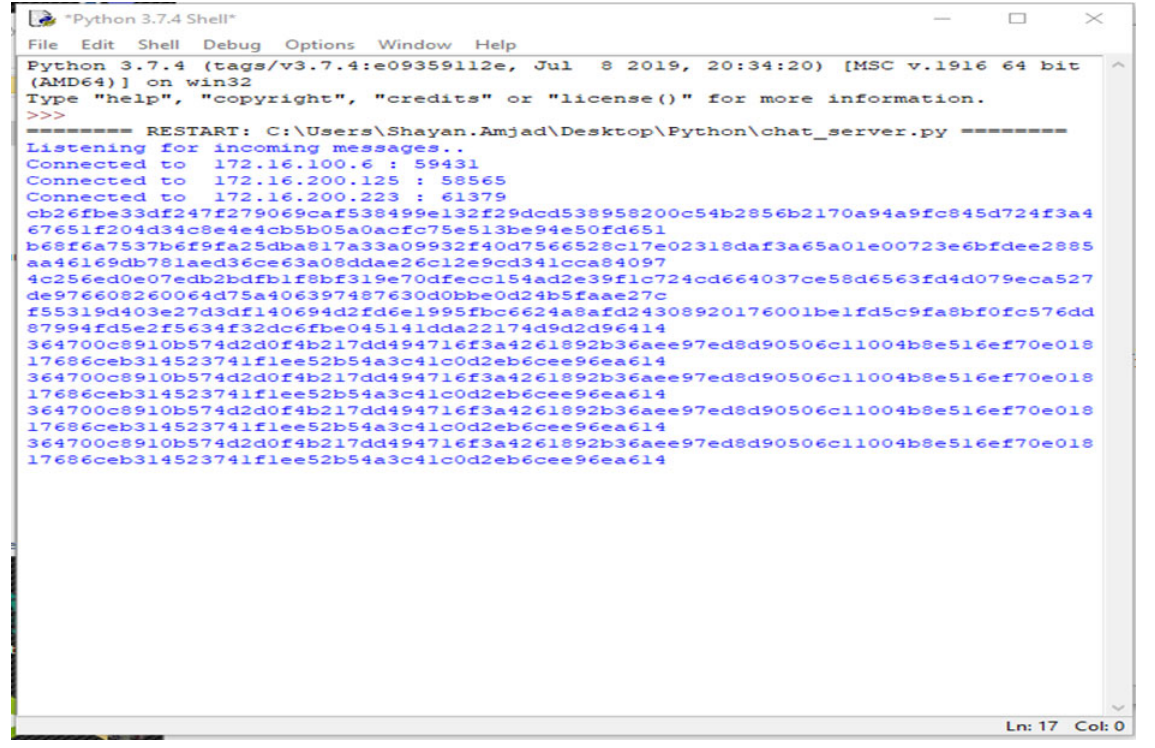
Figure 6. New node joined.